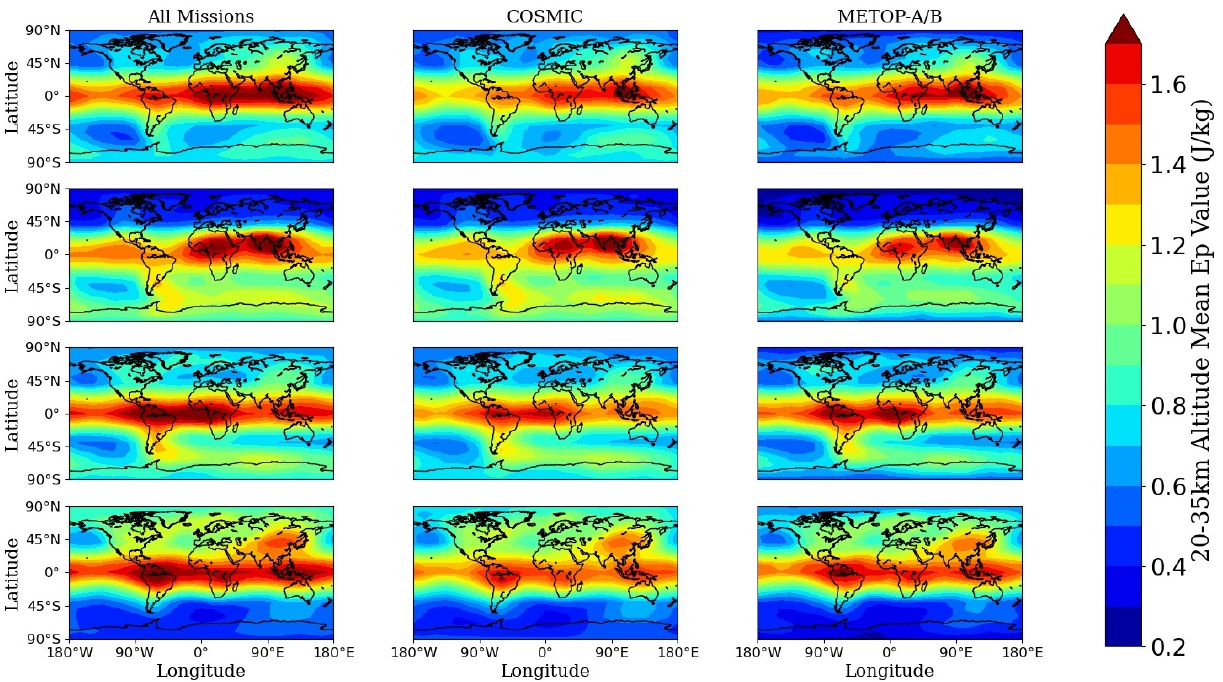
Figure 4. Global distribution of 3 years (from February 2013 to January 2016) GW Ep averaged seasonal means (row 1: MAM, row 2: JJA, row 3: SON, and row 4: DJF) over 20–35 km derived from different datasets.